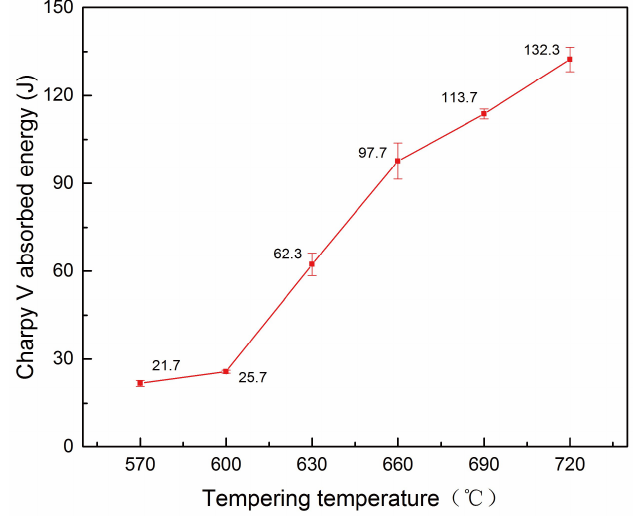
Figure 5. Absorbed energy at −30 °C of 42CrMo4-V steel tempered at different temperature.